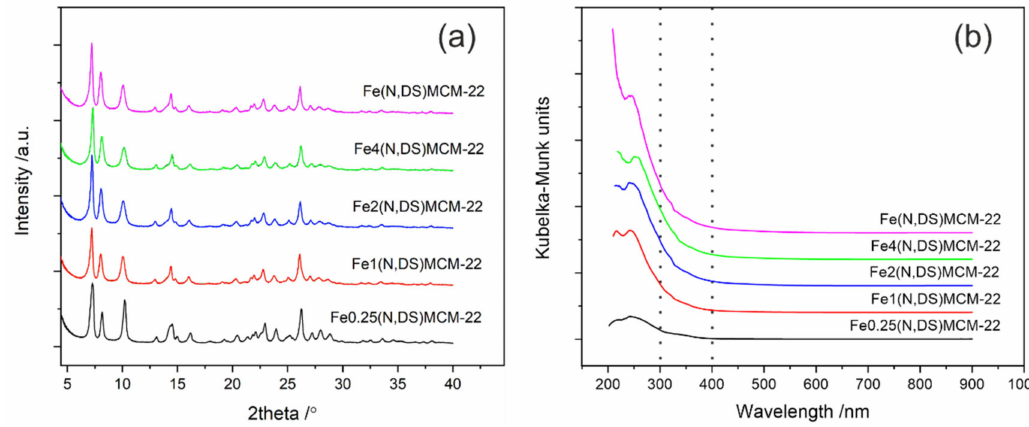
Figure 6. ( a ) XRD patterns and ( b ) UV–vis-DR spectra of the samples from FeX(N,DS)MCM-22 series, modified with iron by direct